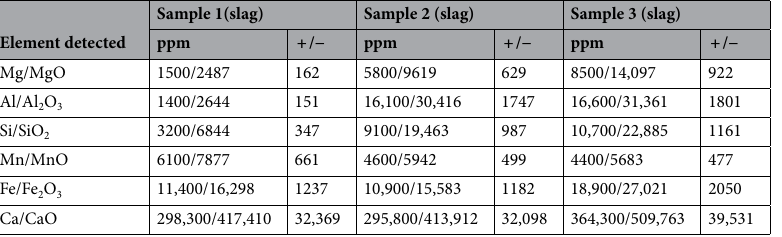
Table 1. XRF analysis of the slag samples.